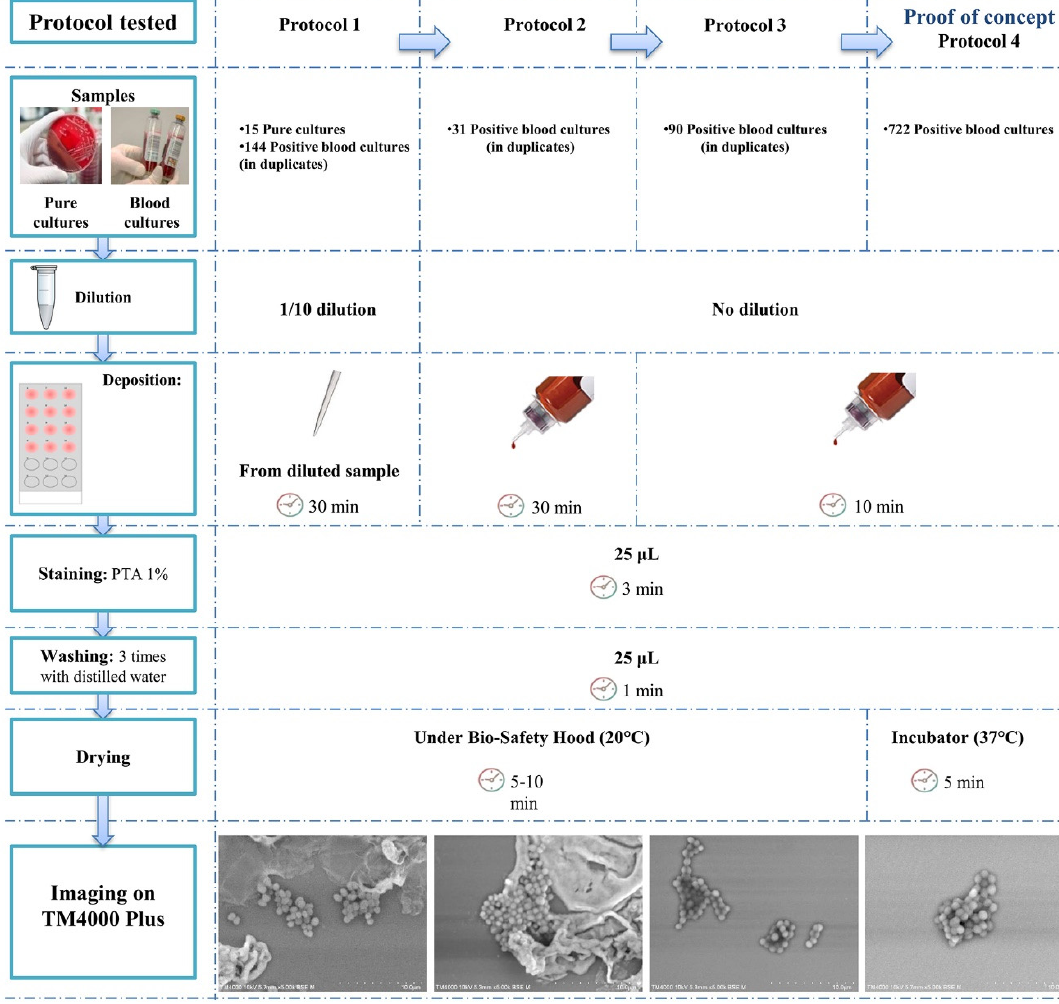
Figure 1. Optimisation of the sample preparation for imaging micro-organisms of 12 positive blood cultures. Reducing the sample preparation time was crucial since we aimed for early and fast identification of the microbes. This protocol was optimised and adapted after many modifications. Protocol 4 showed the best yield for image acquisition and analysis.